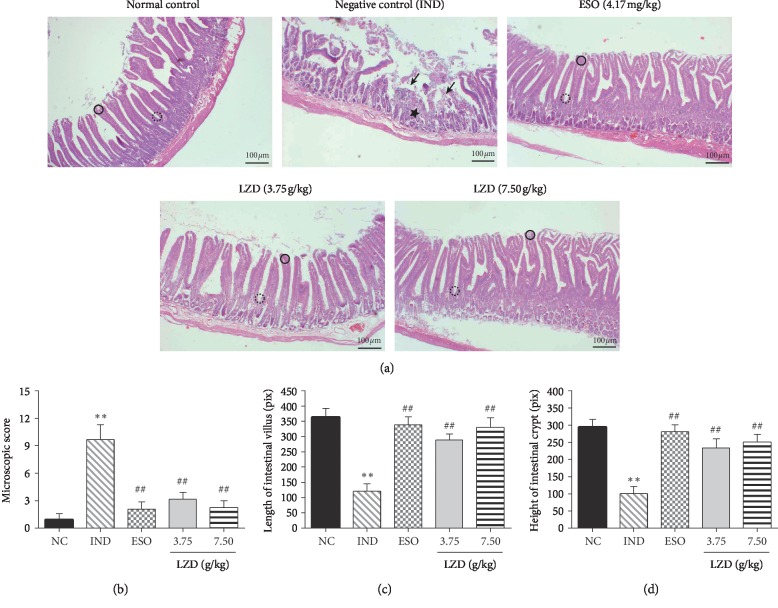
(a) Duodenal histopathology showing the protective effects of LZD on IND-induced histological alteration in rat duodenum. The circles indicate intestinal villi. The dashed circles indicate intestinal crypts. The star indicates infiltration of inflammatory cells. The arrows indicate destruction and desquamation of intestinal villi. (b). Microscopic scores in duodenal tissues of rats of different experimental groups. (c). Histographic representation of villus height change during ulceration and protection. (d). Histographic representation of crypt depth change during ulceration and protection. Vertical bars represent standard errors of the means, n = 6. Asterisks and pound signs indicate significant differences: ∗∗P < 0.01 versus normal control (NC); ##P < 0.01 versus negative control (IND).